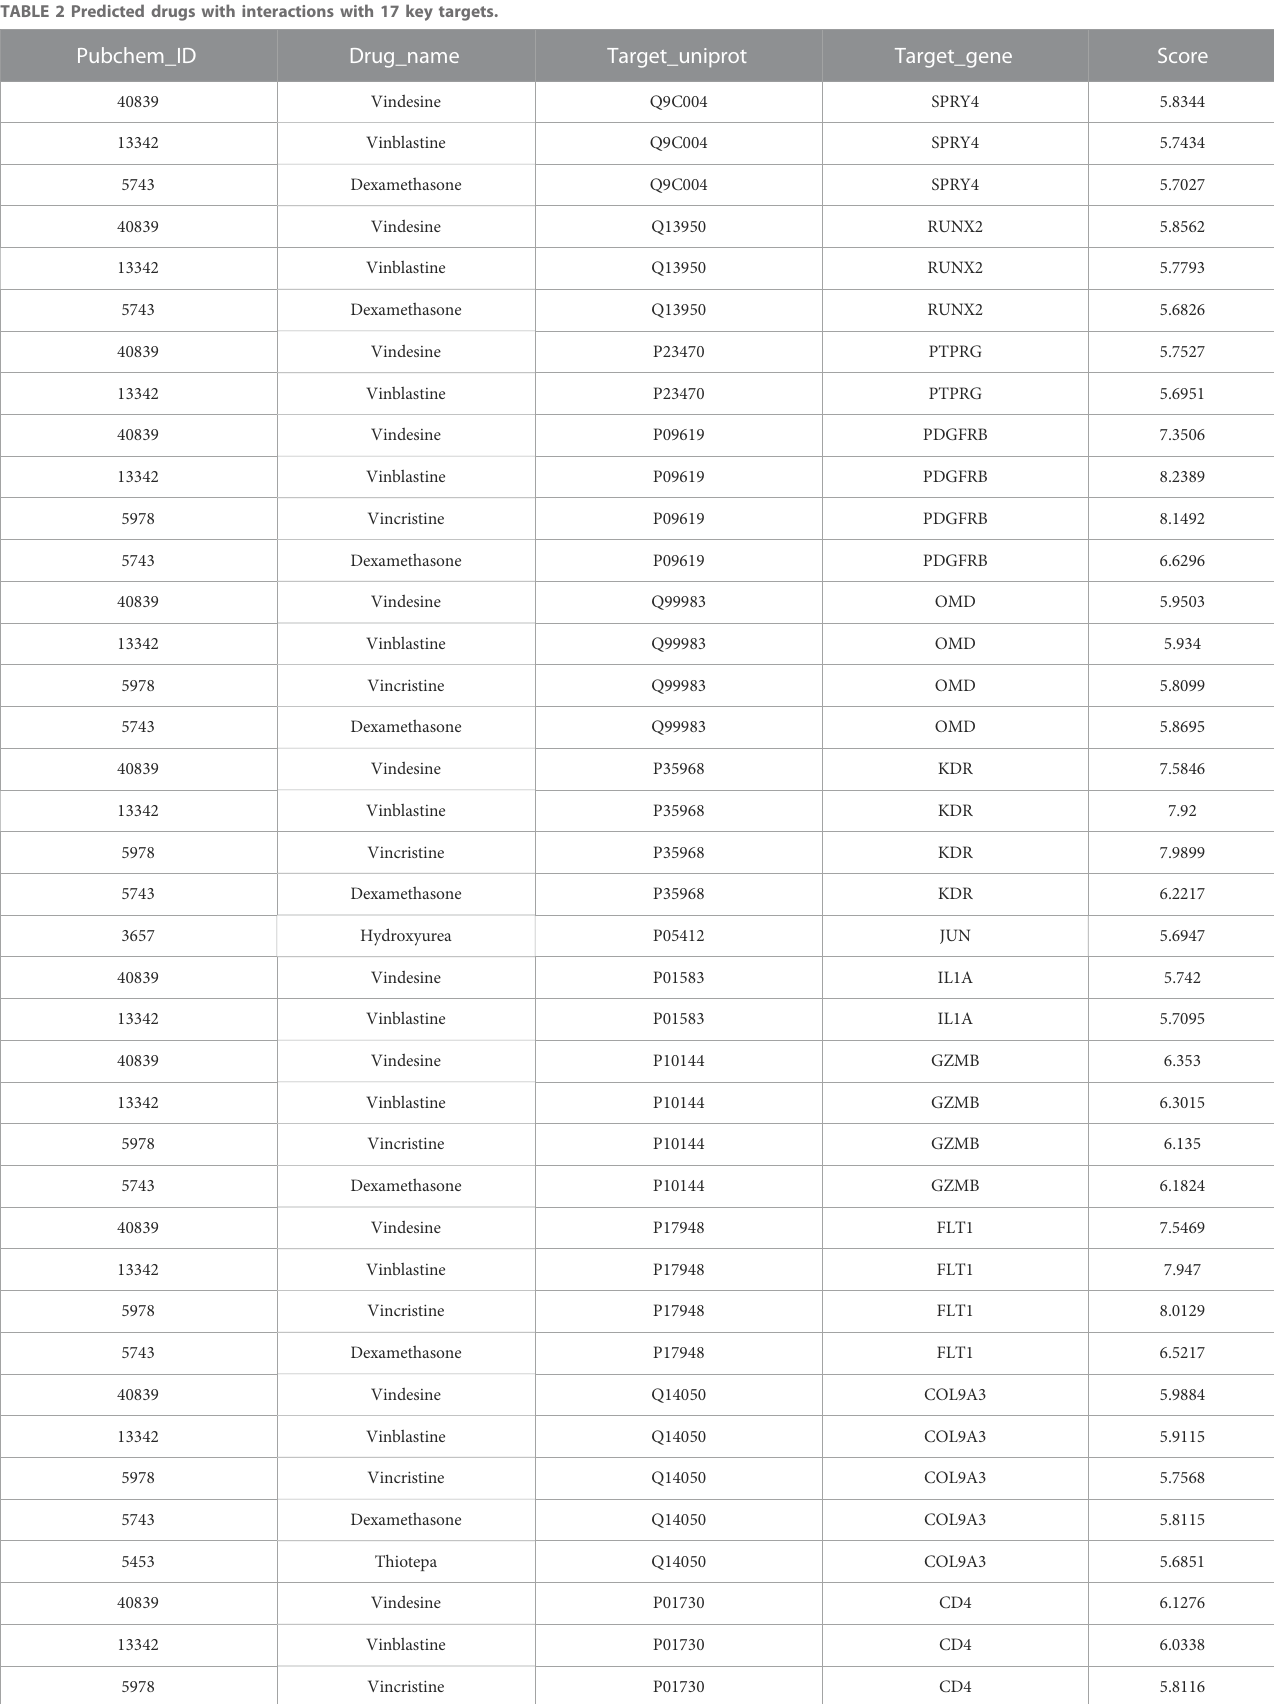
TABLE 2 Predicted drugs with interactions with 17 key